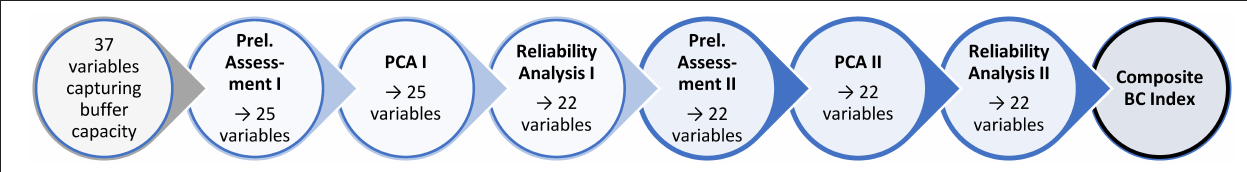
= 0.091, p = 0.018]. Three respondents with scores above 6.32 were